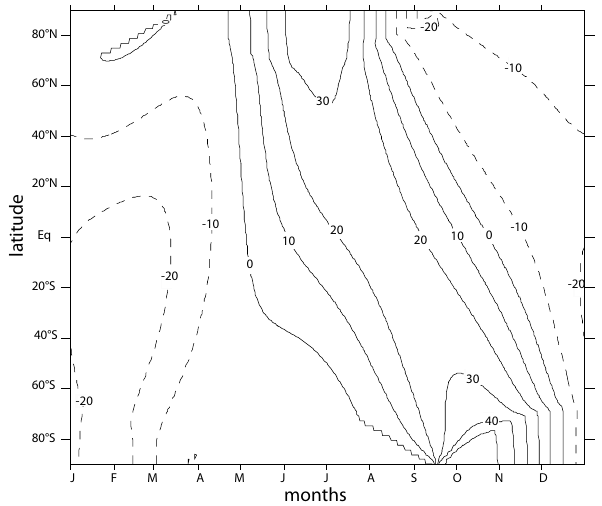
Figure 1. Anomalies (MIS4_min-MIS4_max) in incoming solar ra- diation at the top of the atmosphere (Wm − 2 ) averaged over the longitude and plotted as a function of months. The figure has been plotted based on the daily insolation